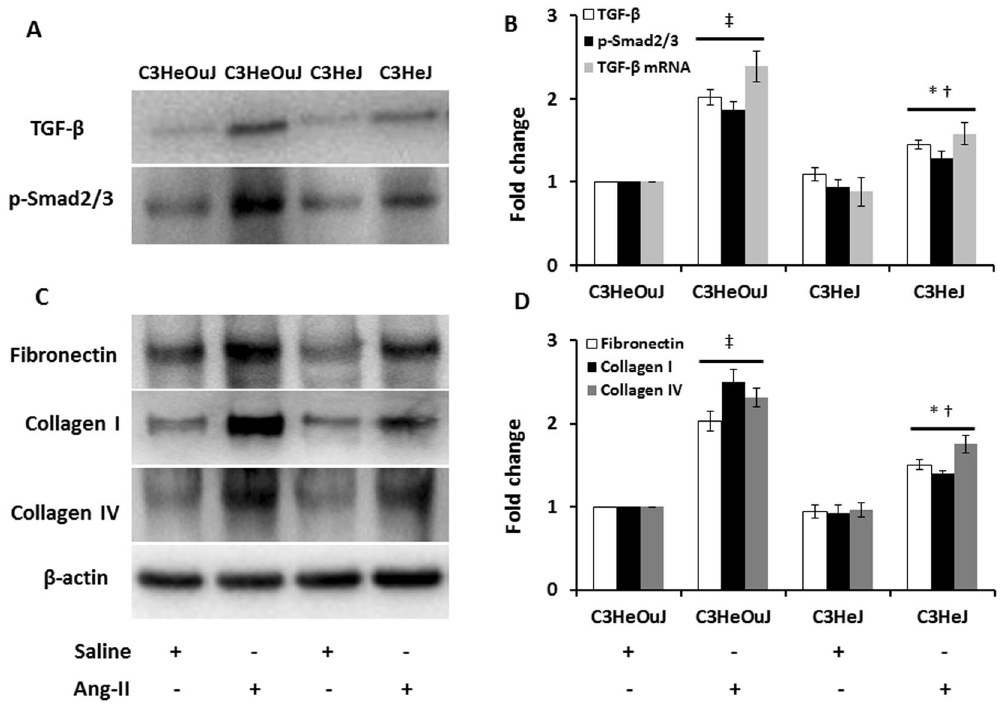
Figure 9. TLR4 deficiency decreases the expression and level of TGF- β , p-Smad2/3 and extracellular matrix proteins in Ang-II treated mice. ( A ) Representative cropped immunoblot images for TGF- β , p-Smad2/3, ( B ) mRNA fold change of TGF- β assessed by real-time PCR, ( C ) Representative cropped immunoblot images for fibronectin, collagen I and collagen IV, ( B , D ) Data was normalized to β -actin and presented as mean ± SEM. n = 6/ group, tested by Kruskal-Wallis test and Mann-Whitney rank sum test. * p < 0.05 vs. C3HeJ + saline, † p < 0.05